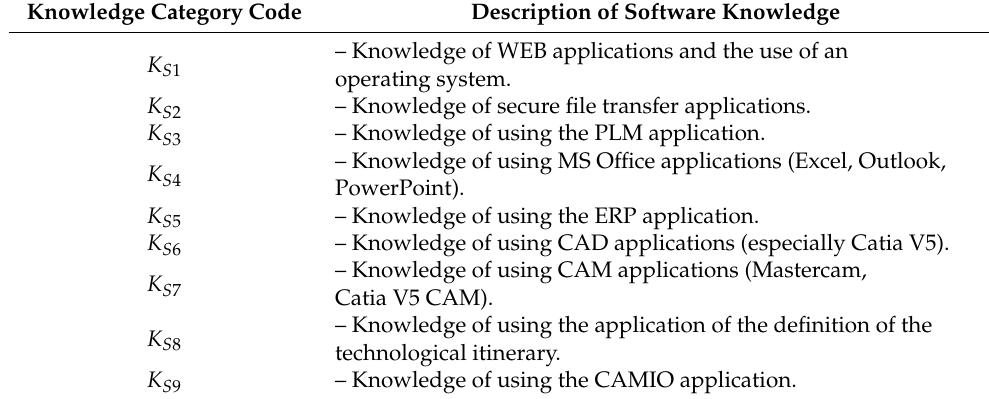
Table 10. Software knowledge list.